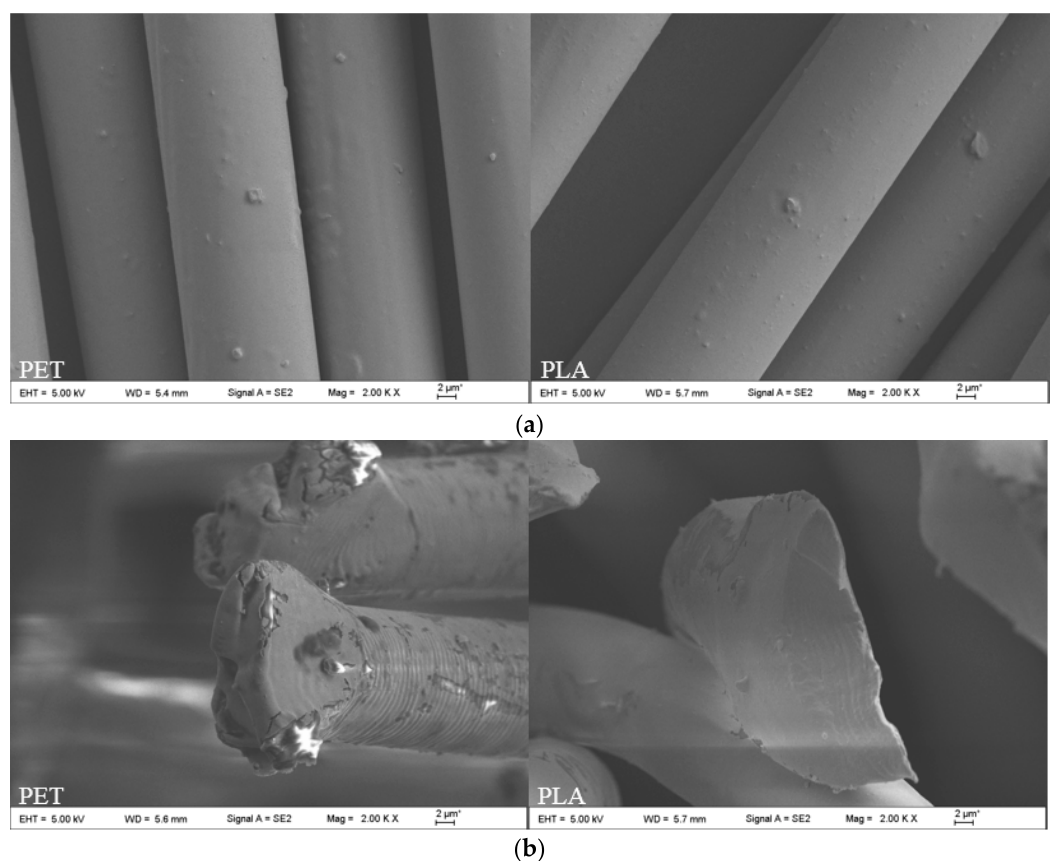
Figure 5. Electron micrograph of PLA multifilament: ( a ) longitudinal section morphology; ( b ) cross-section morphology.